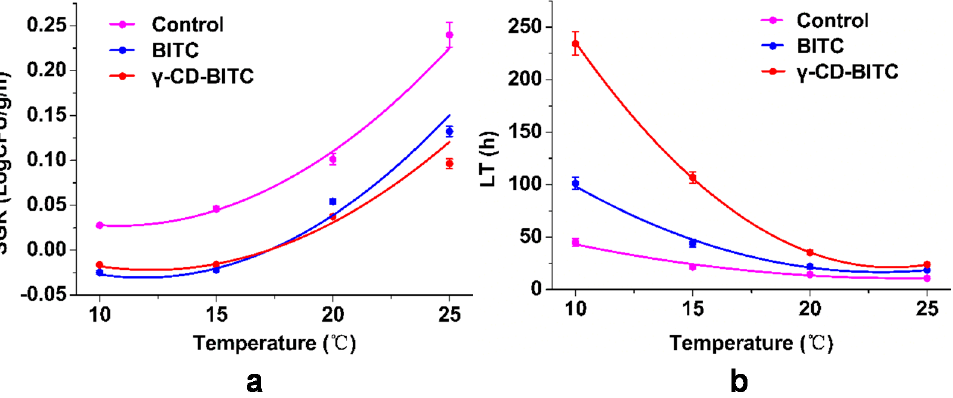
Figure 7. The secondary model for growth factors of the inhibitory effects of BITC and γ -CD-BITC on S. aureus in cooked chicken breast stored at 10, 15, 20, and 25 °C. ( a ) SGR, maximum specific growth rate and ( b ) LT, lag time.